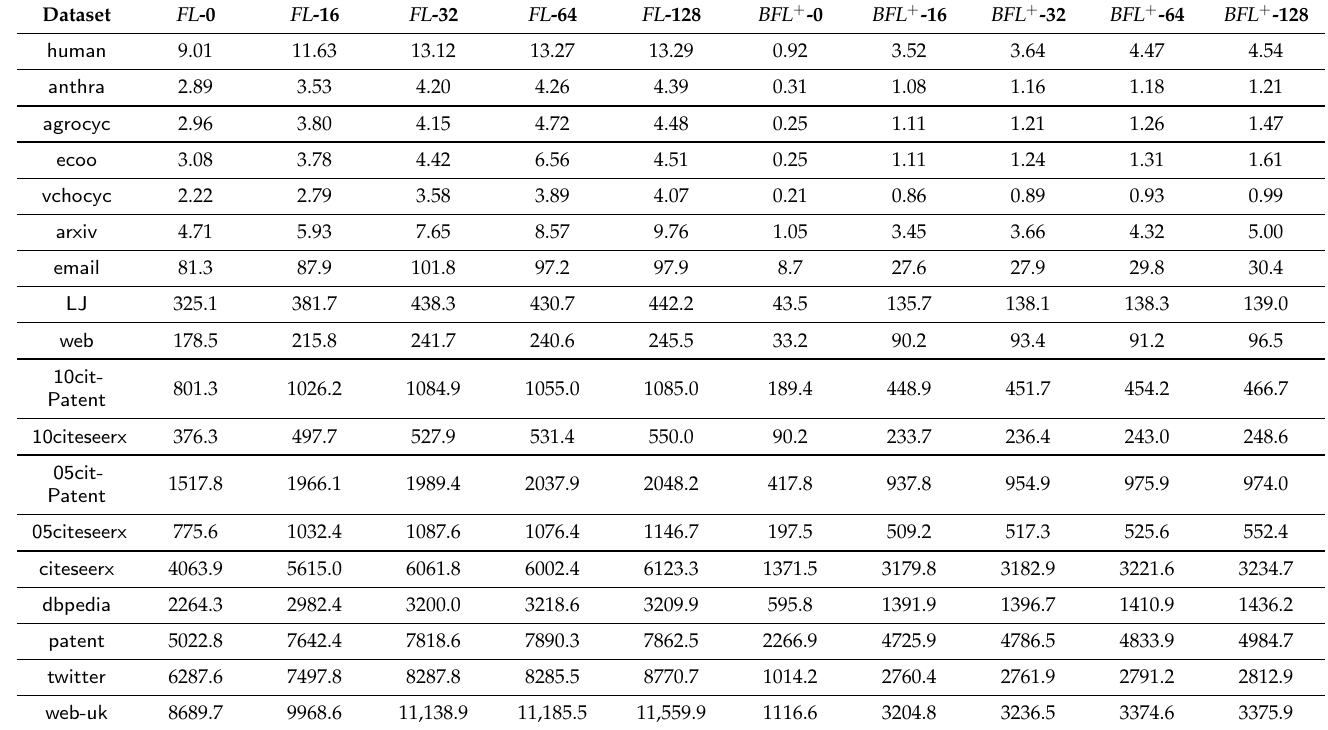
Table 5. Comparison of the index construction time